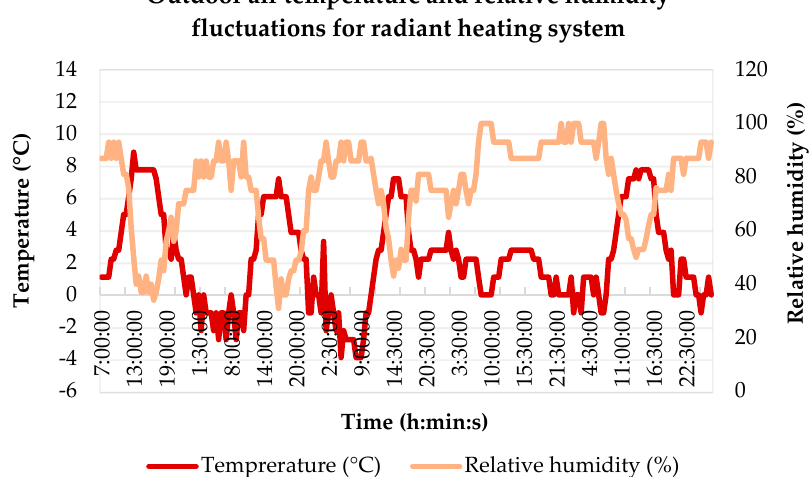
Figure 8. Outdoor air temperature and relative humidity fluctuations for RHS [32].